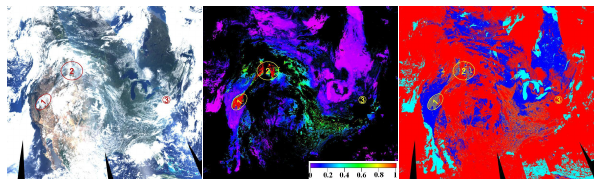
Figure 2. MODIS top-of-atmosphere RGB image (left), AOT at 470nm retrieved from MODIS with the MAIAC algorithm (mid- dle), and cloud mask (right). Cloud mask legend: red/yellow – clouds; blue/light blue – clear over land/water; grey – smoke aerosol. The ovals point to Yosemite (1) and Idaho/Wyoming (2) fires, and the GSFC location